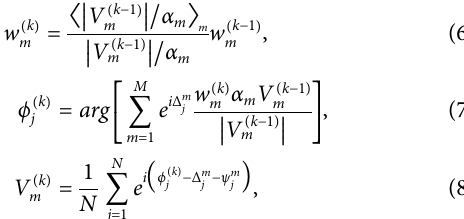
intensity patterns on the Fourier plane of the GP, OV +15 , PV 0, and Airy beam are shown in Figure 2 .